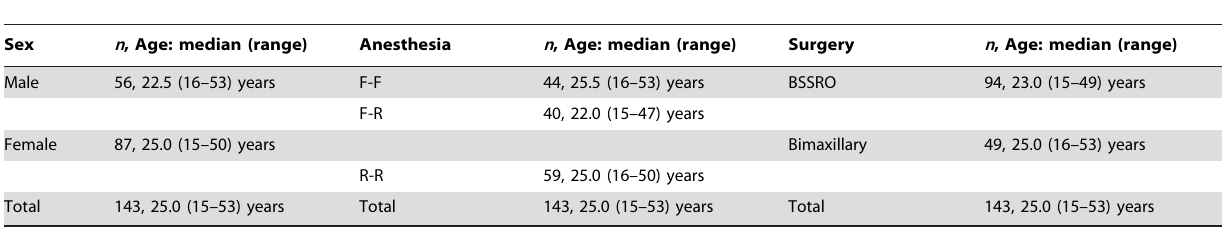
Table 1. Number of patients, age, sex, anesthesia methods, and surgical methods.